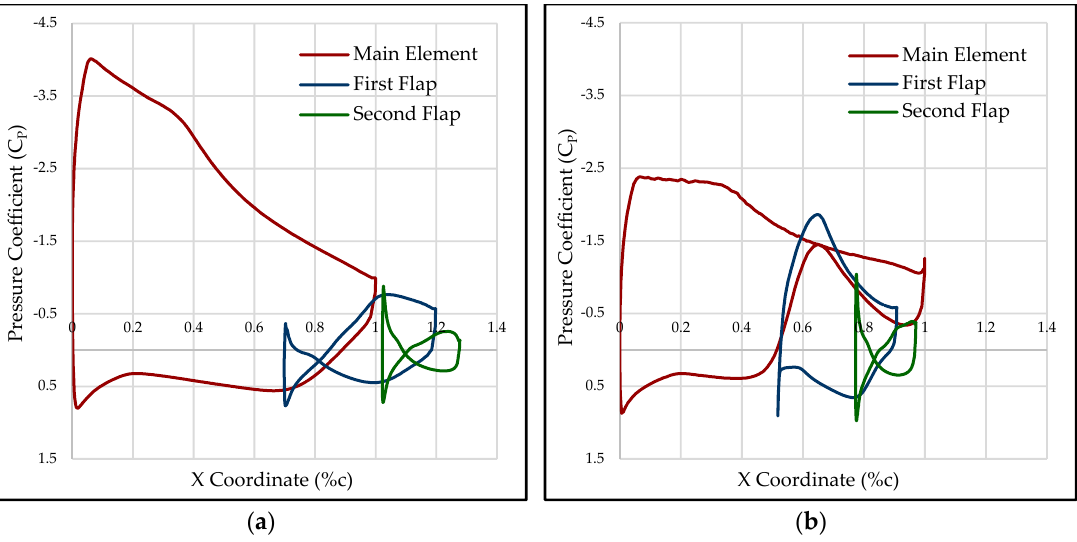
Figure 13. Pressure distribution in the three elements of the 2022 F1 front wing at sections: ( a ) 0.05 s; ( b ) 0.95 s.